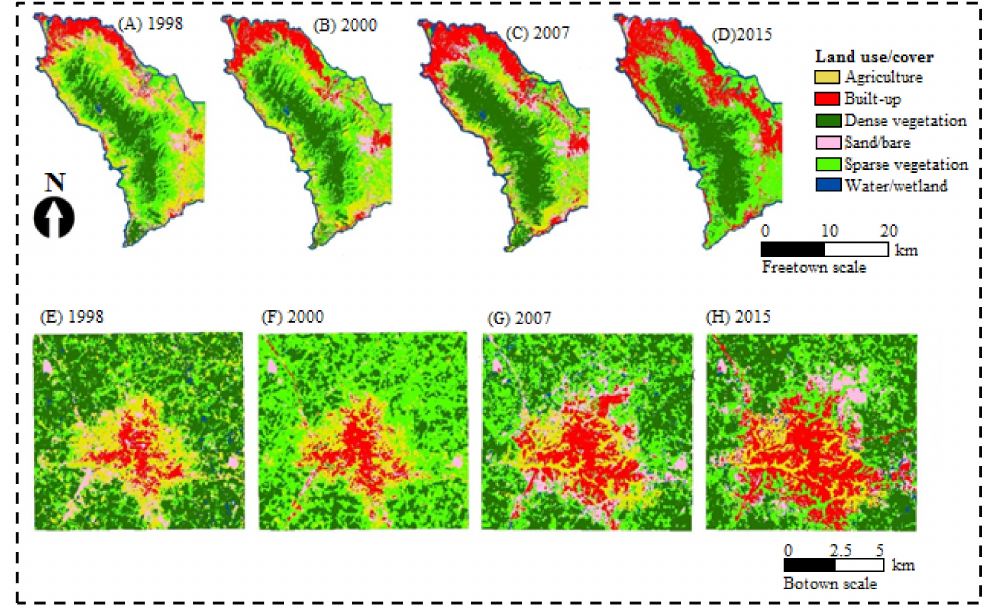
Figure 2. Urban growth induced LULC changes in Freetown ( A – D ) and Bo town ( E – H ) between 1998 and 2015.